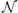
Empirical distribution functions.Left panel: pdf of a random variable N
(0,1) (red dashed line) and of the sampled process ztFR with a sampling interval of 1 minute (illiquid data). Right panel: pdf of a random variable N
(0,1) (red dashed line) and of the sampled process ztFR with a sampling interval of 1 minute (liquid data).